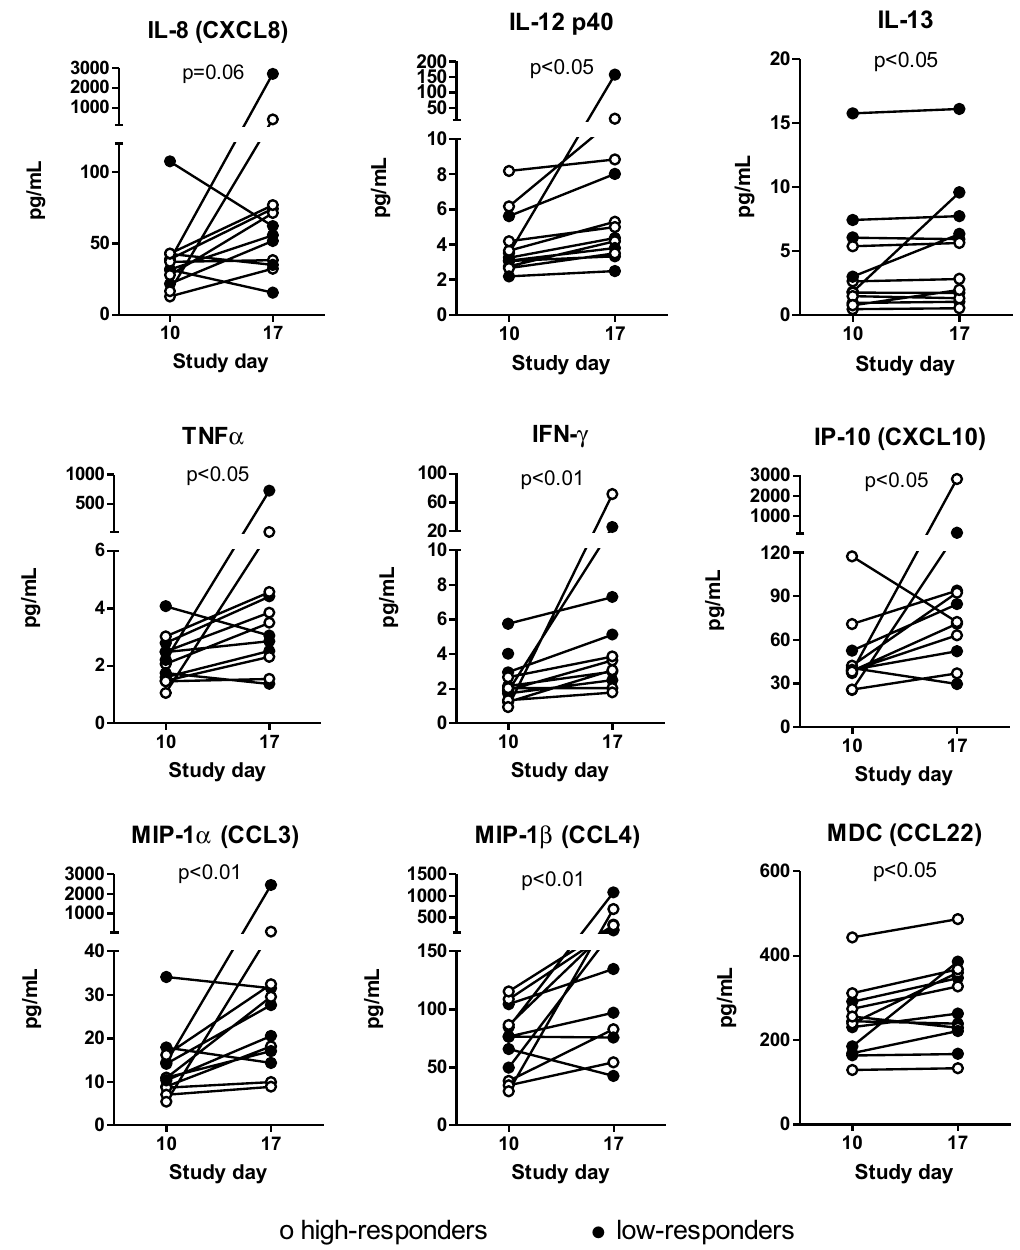
Figure 5. Ex vivo cytokine and chemokine production in whole blood before and after E. coli challenge. Ex vivo stimulation of whole blood cells was performed in a subset of subjects (n = 6 low-responders, closed circles, and n = 6 high-responders, open circles). Subjects were orally infected with a live attenuated E. coli strain E1392/75-2A on study day 14. Whole blood stimulation was performed on study day 10 and 17, using Null TruCulture tubes (medium only). No difference was observed between low- and high-responders, therefore the data of both subgroups were combined in statistical analysis. From the total panel of cytokines and chemokines that were analysed, the figures are shown for those that changed (borderline) significantly after challenge (Wilcoxon Signed Rank